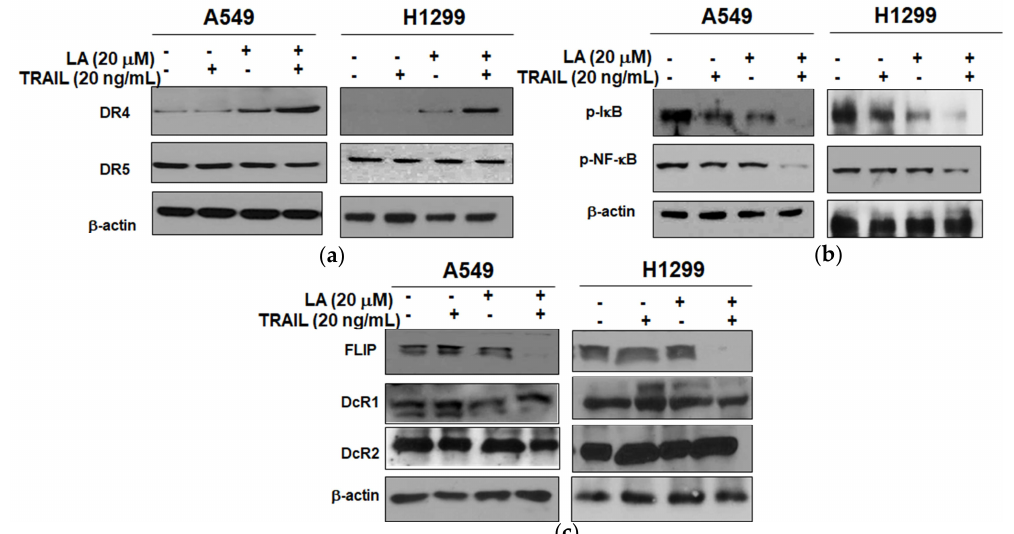
Figure 4. Combined effect of LA and TRAIL on the expression of DR4, p-NF- κ B, p-I κ B, and FLIP in A549 and H1299 cells. Cells were treated with LA (20 µ M) and/or TRAIL (20 ng/mL) for 24 h and cell lysates were prepared and subjected to Western blotting. ( a ) Combined effect of LA and TRAIL on the expression of DR4 and DR5 in A549 and H1299 cells. ( b ) Combined effect of LA and TRAIL on the expression of p-NF- κ B and p-I κ B in A549 and H1299 cells. ( c ) Combined effect of LA and TRAIL